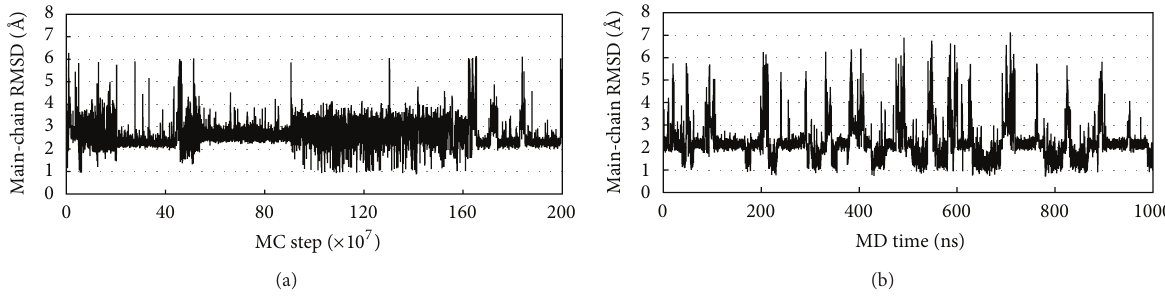
Figure 6: Traces of the main-chain RMSD obtained for chignolin by the SAAP-MC (trajectory 10) (a) and AMBER-MD (trajectory 1) (b) simulations at 300 K in water. The RMSD values were calculated with respect to the native